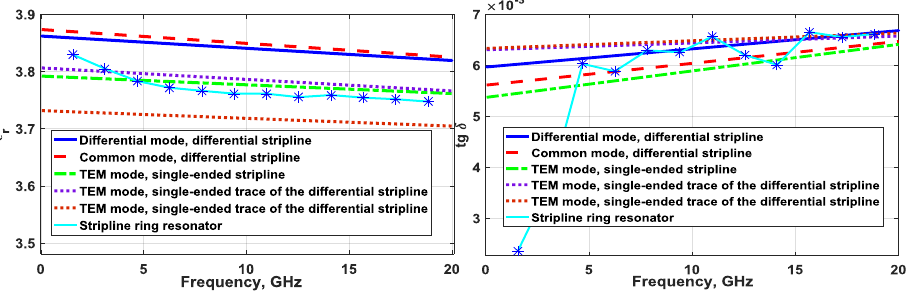
Fig. 5. Measured dielectric parameters on the different types of transmission lines and